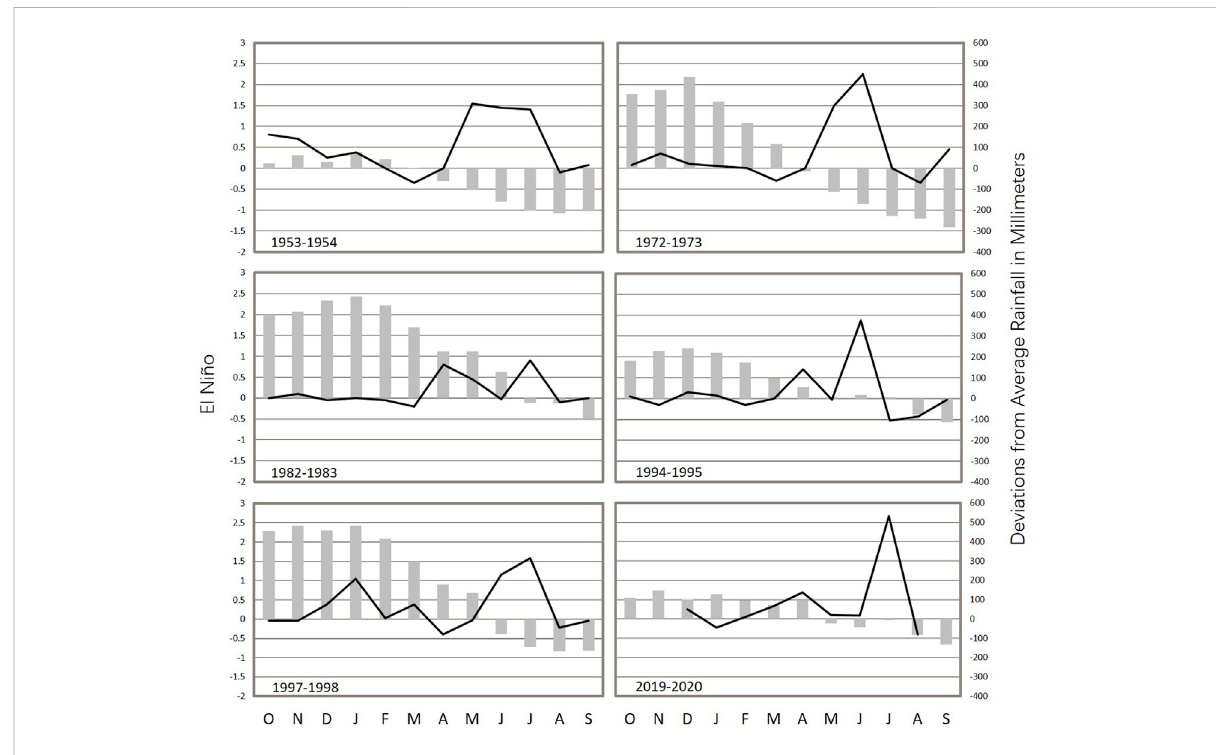
FIGURE 3 El Nino-3.4 and Nanchang, Jiangxi, rainfall deviations from average preceding and during severe fl oods occurring 1954 –